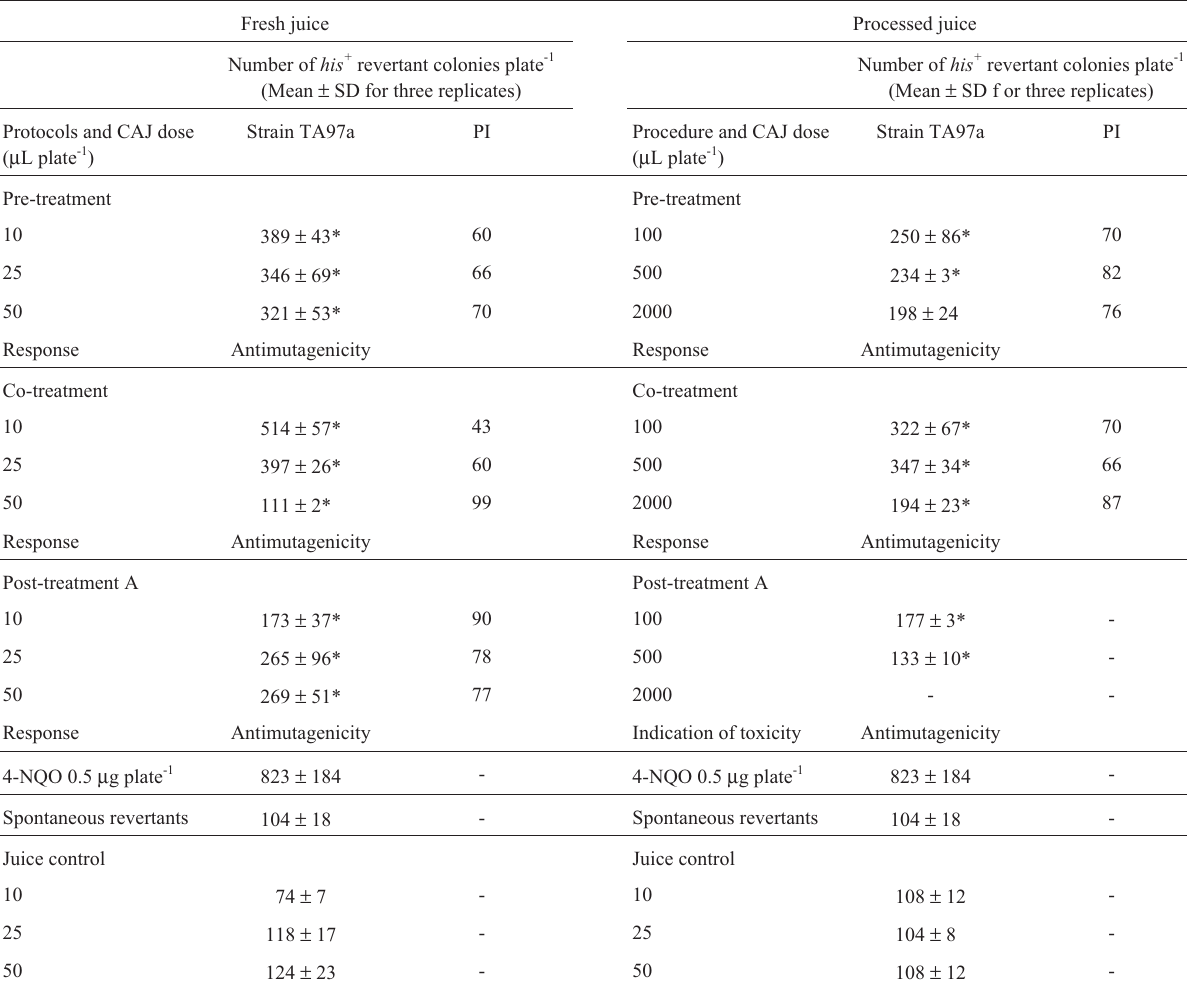
Table2 -Effectsofcashewapplejuice(CAJ)against4-nitroquinolineN-oxide(4-NQO)using Salmonellatyphimurium strainTA97aasindicatororgan- ism. Percentageinhibition(PI)calculatedasPI=[1-(B-A/B)]X100,whereArepresentsplatescontainingmutagensandBrepresentstheplatecontain- ingmutagensandjuice(Melo-Cavalcante etal. ,2003)Antimutagenicity=PI ≥ 50%. Indicationoftoxicitywhenthenumberofrevertantcolonies<70% comparedtonumberofspontaneousrevertants.Co-mutagenicitywhenthereisasignificantincreaseinmutagenicityascomparedtopositivecontrol.The number of spontaneous revertants was subtracted from all plates. Values are means ± standard deviations (SD). Protocols for CAJ testing: pre-treatment, juice + bacteria in fresh nutrient broth for 4 h, wash bacteria and add mutagen for 20 min, wash bacteria and plate; co-treatment A, juice + mutagen for 20 min, add to the bacteria and plate; and post-treatment, bacteria + mutagen for 20 min, wash bacteria, add the juice and